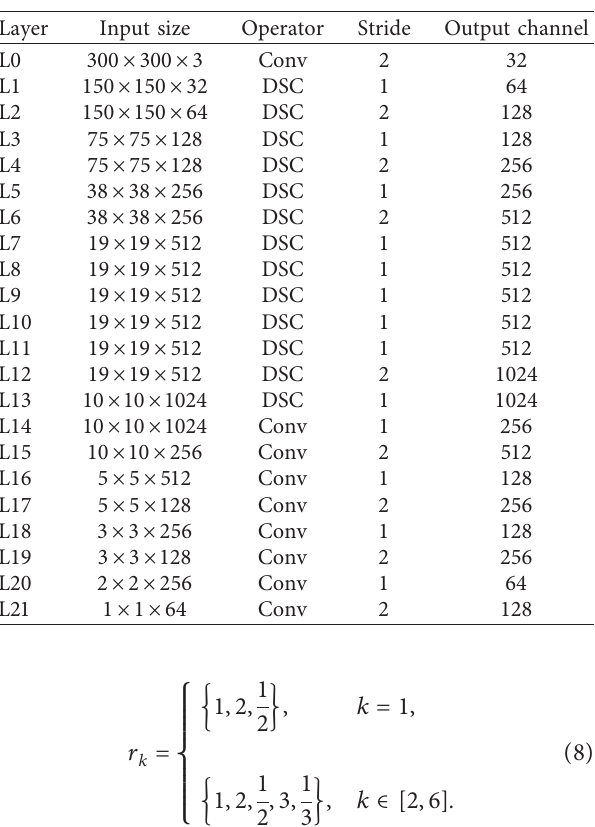
Table 1: The backbone of